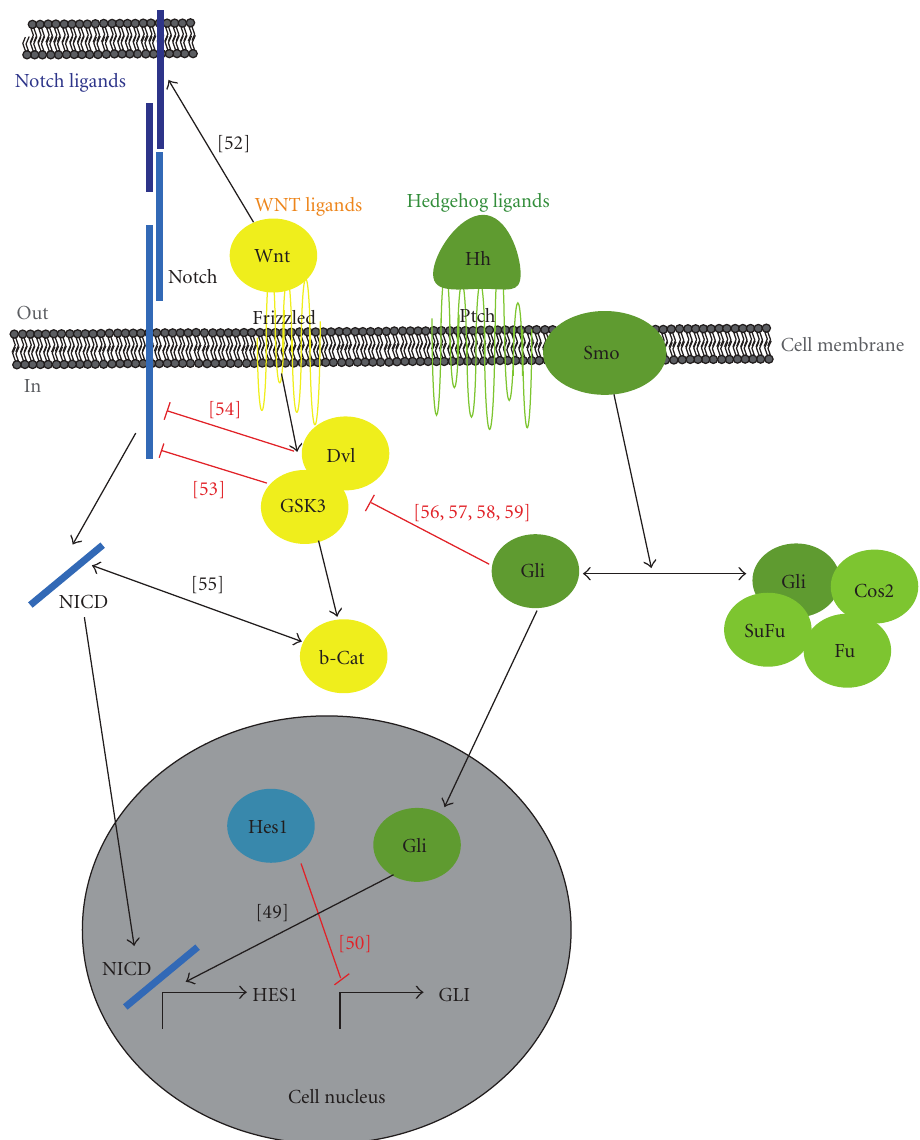
Figure 1: Schematic simplified view of Notch (blue), Wnt (yellow), and Hedgehog (green) signalling pathways and the most significant horizontal interactions among them. Black arrows indicate activating interactions. Red lines indicate inhibiting